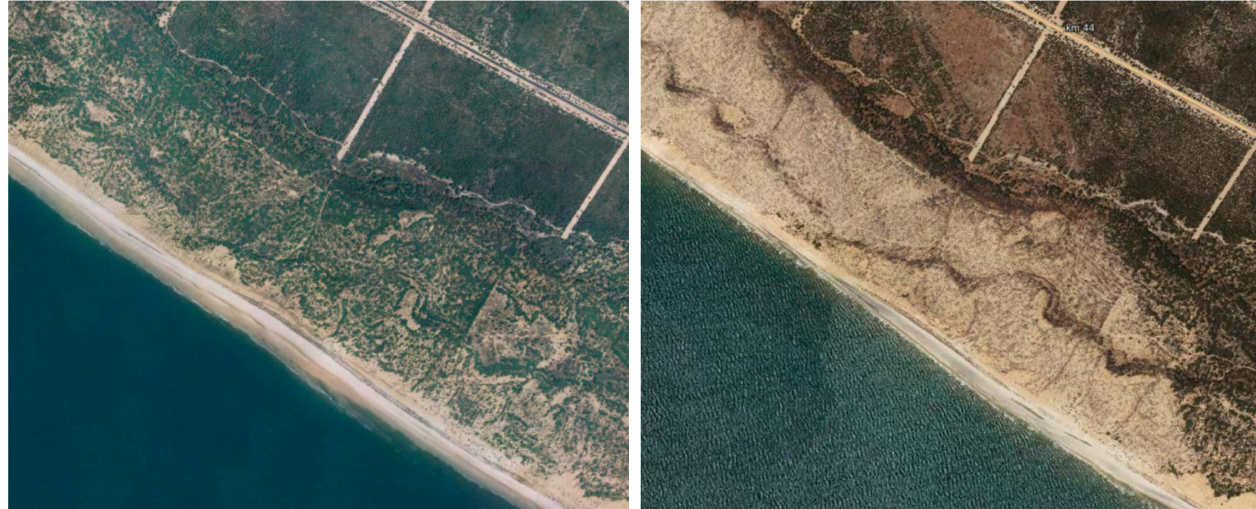
Figure 2. Comparison of the situation of some areas of the park between 2007 and 2020.